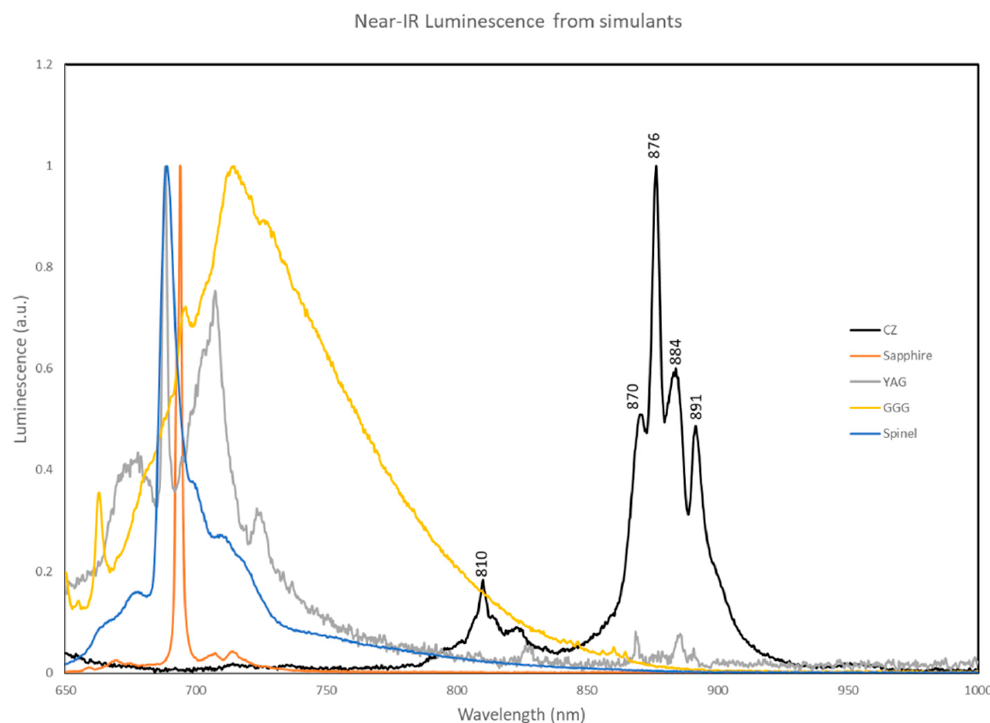
Figure 1. Near-infrared delayed luminescence spectra of common simulants measured on Horiba iHR-320 spectrometer, excitation at 550 nm (see Section Materials and Methods).